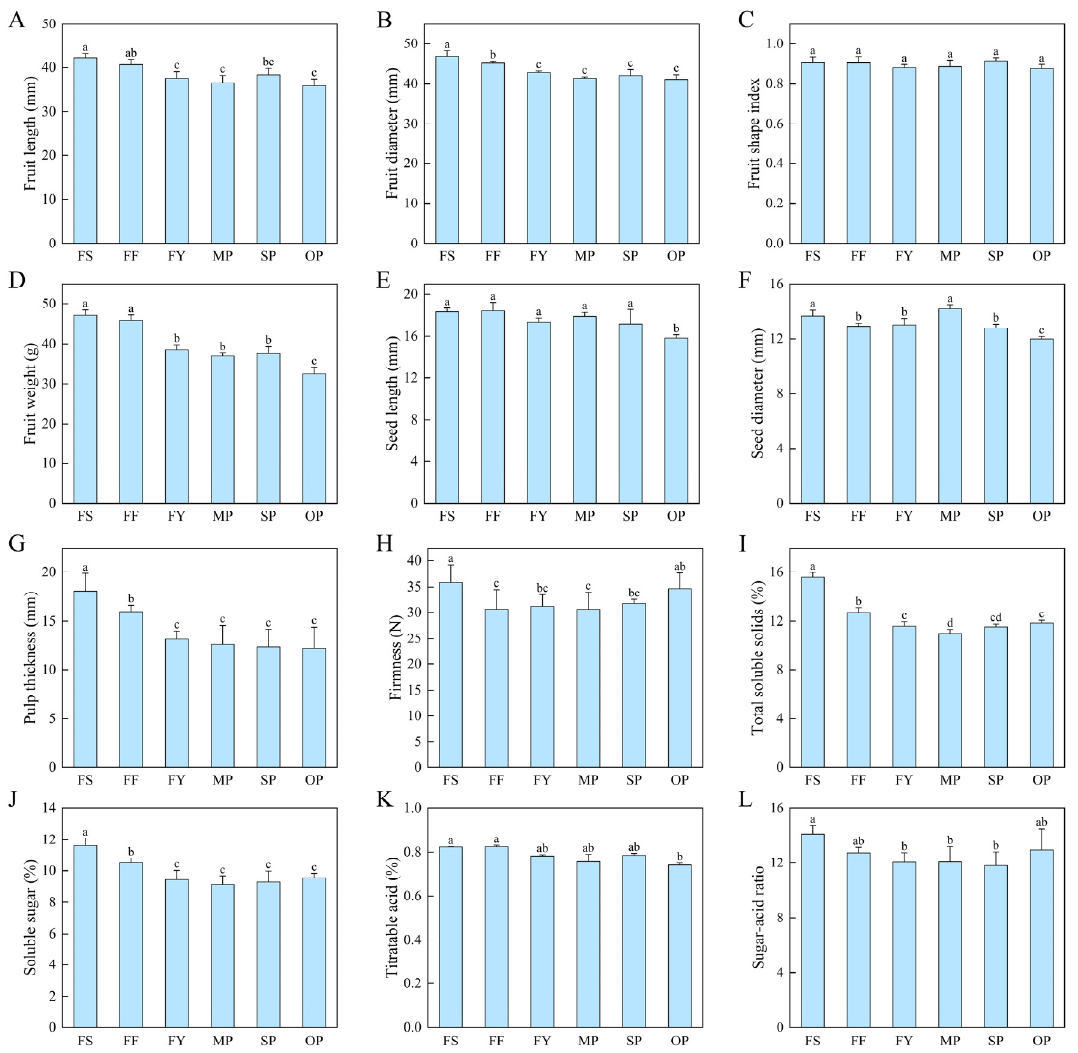
Figure 3. Fruit length ( A ), fruit diameter ( B ), fruit shape index ( C ), weight ( D ), seed length ( E ), seed diameter ( F ), pulp thickness ( G ), firmness ( H ), total soluble solids content ( I ), soluble sugar content ( J ), titratable acid content ( K ), and sugar-acid ratio ( L ) of ‘Fengtangli’ plum with different pollination treatments. Error bars indicate the standard deviation of total substance content, and different letters indicate significant differences in fruit characteristics, p <